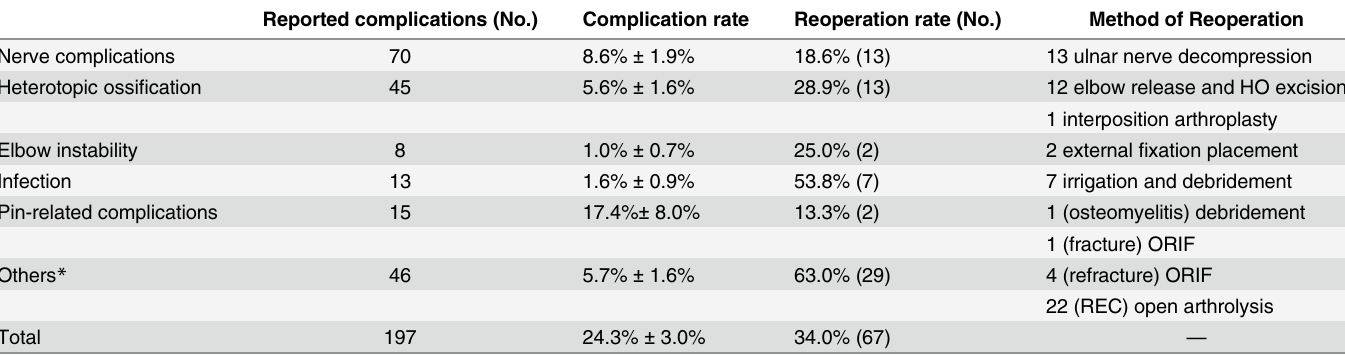
Table 3. Summary of the reported complications.